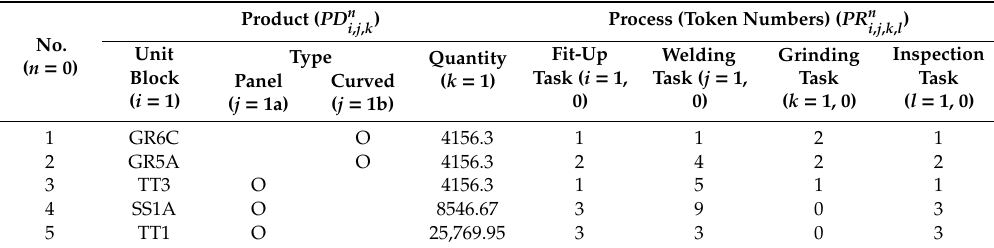
Table 5. An example of the TT1 block-based product and process among the PPR-SS through the process-based Petri-net model.